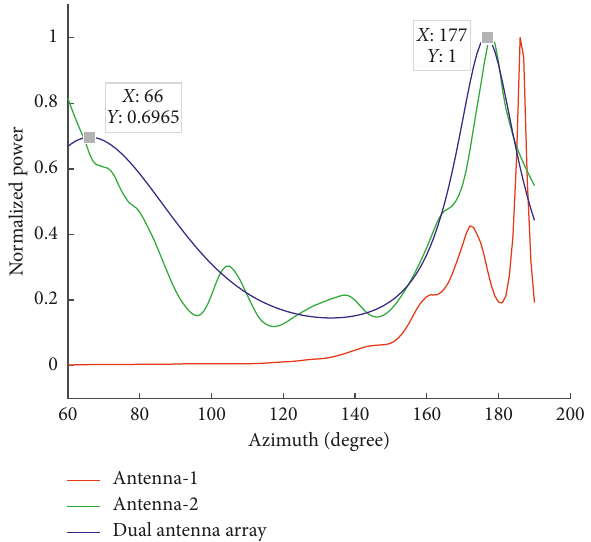
Figure 9: Normalized MUSIC spectrum of targets with actual azimuths of 65 ° and 177 °